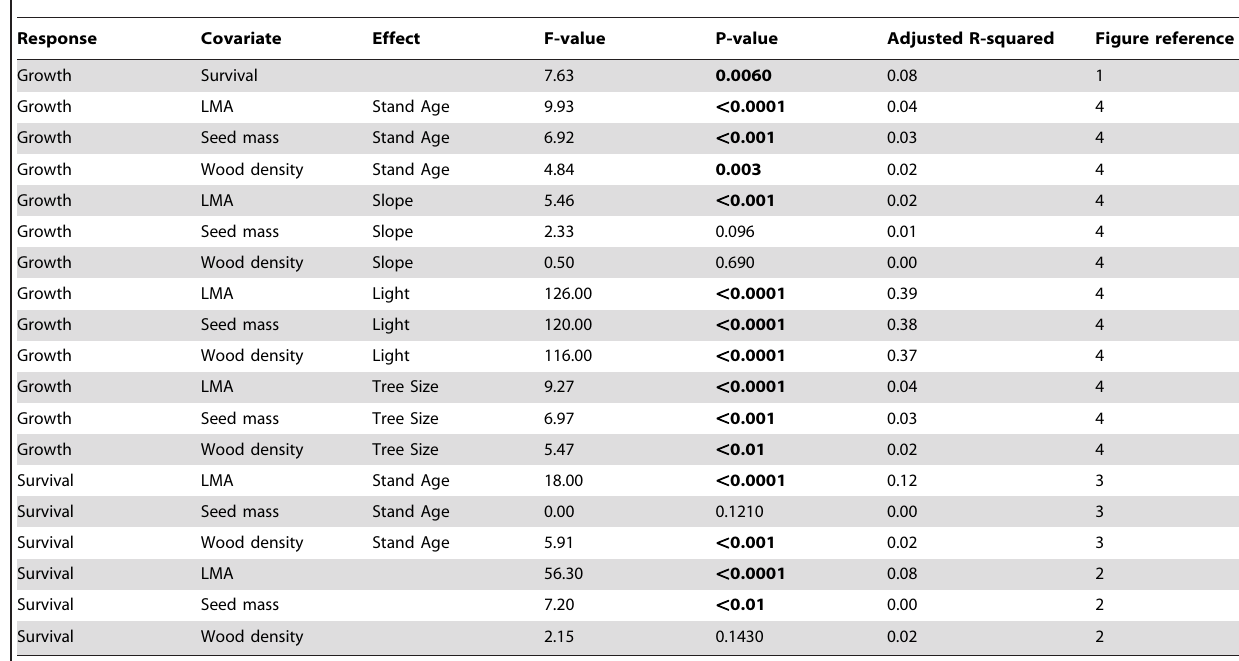
Table 1. Individual regressions and